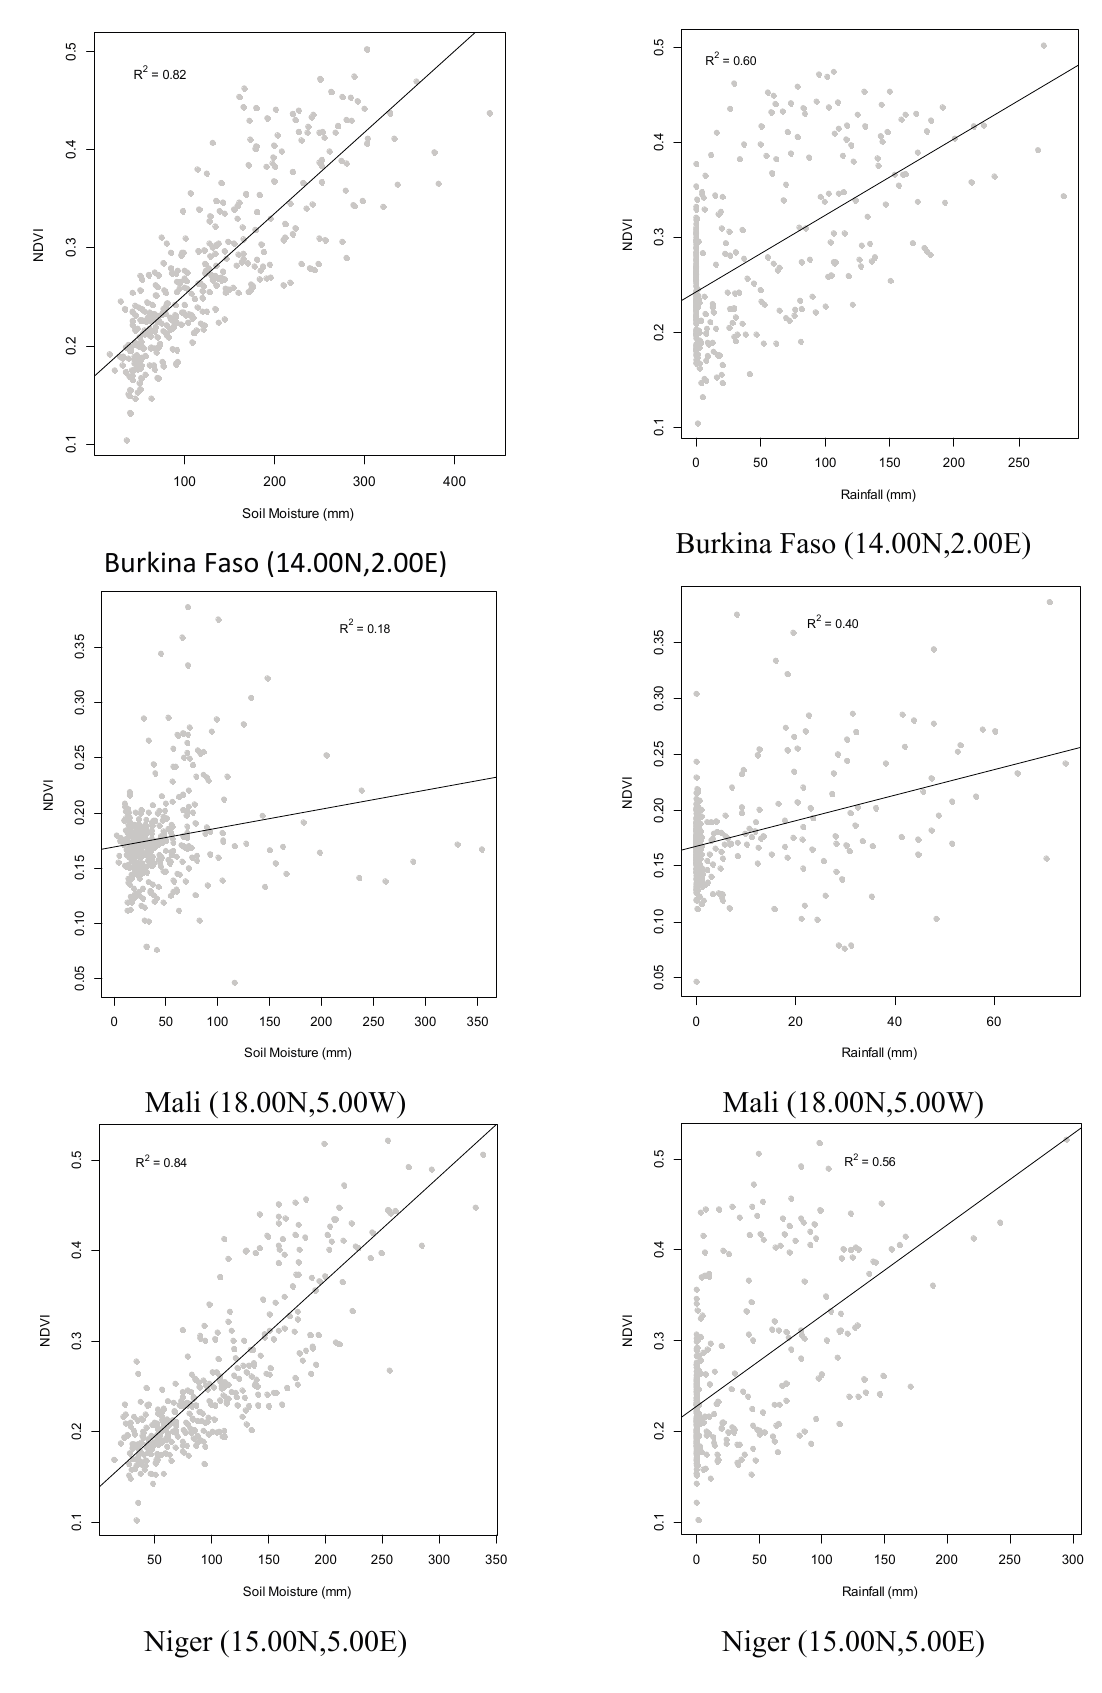
Figure 7. Comparison between the correlation coefficients of NDVI and soil moisture; and NDVI and rainfall across the six sampling sites in the study